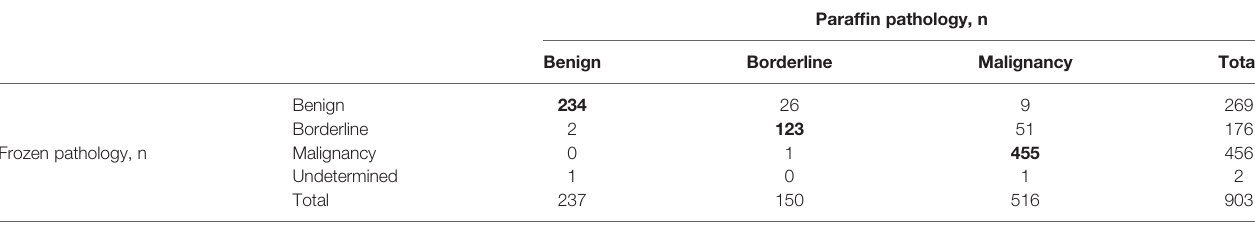
TABLE 3 | Comparison of the intraoperative frozen pathology and fi nal paraf fi n pathology of the 903 ovarian tumors.